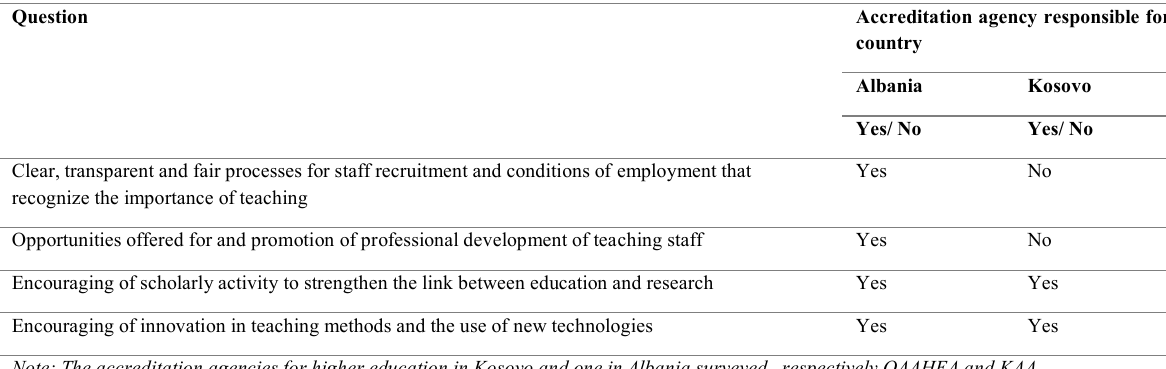
Table 15: Internal quality assurance: Teaching staff (KAA and QAAHE)